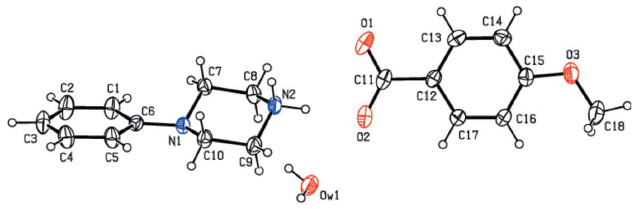
Figure 2 The independent components of compound ( II ) showing the atom- labelling scheme. Displacement ellipsoids are drawn at the 30% probability level.